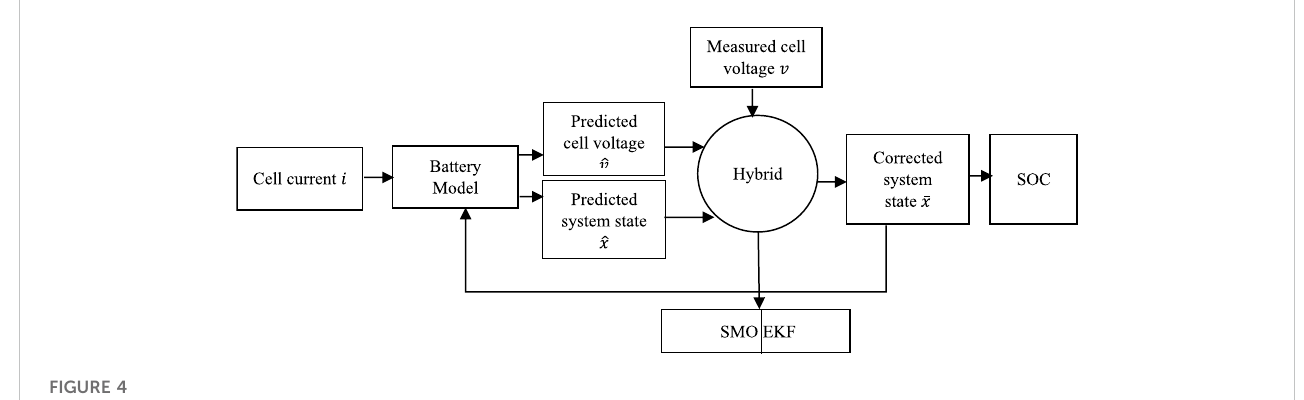
FIGURE 4 Block diagram of the hybrid SOC